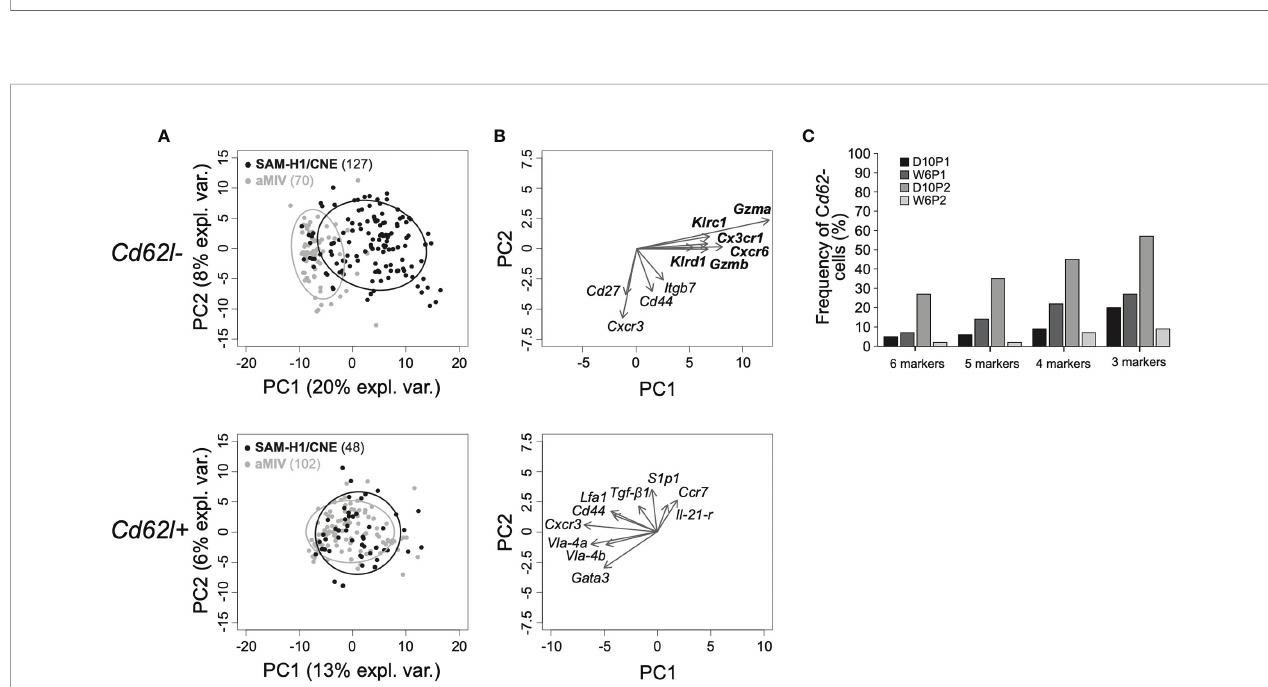
FIGURE 4 | Genes characterizing Cd62l- pent+CD8 T cells induced by SAM-H1/CNE at D10P2. (A) Representation of individual Cd62l - (top panel) and Cd62l + (bottom panel) pent+CD8+ T cells induced by SAM-H1/CNE (black) or aMIV (grey) on the fi rst two principal components for the D10P2 time point. (B) Loading plots representing the ten most informative genes. (C) Co-expression analysis of genes driving the segregation between Cd62l- pent+CD8+ T cells induced by SAM-H1/ CNE- and aMIV. 6 markers: Klrc1 , Gzma , Cx3cr1 , Cxcr6 , Gzmb and Klrd1 . 5 markers: Klrc1 , Gzma , Cxcr6 , Gzmb and Klrd1 . 4 markers: Klrc1 , Gzma , Cxcr6 and Gzmb . 3 markers: Gzma , Cxcr6 and Gzmb